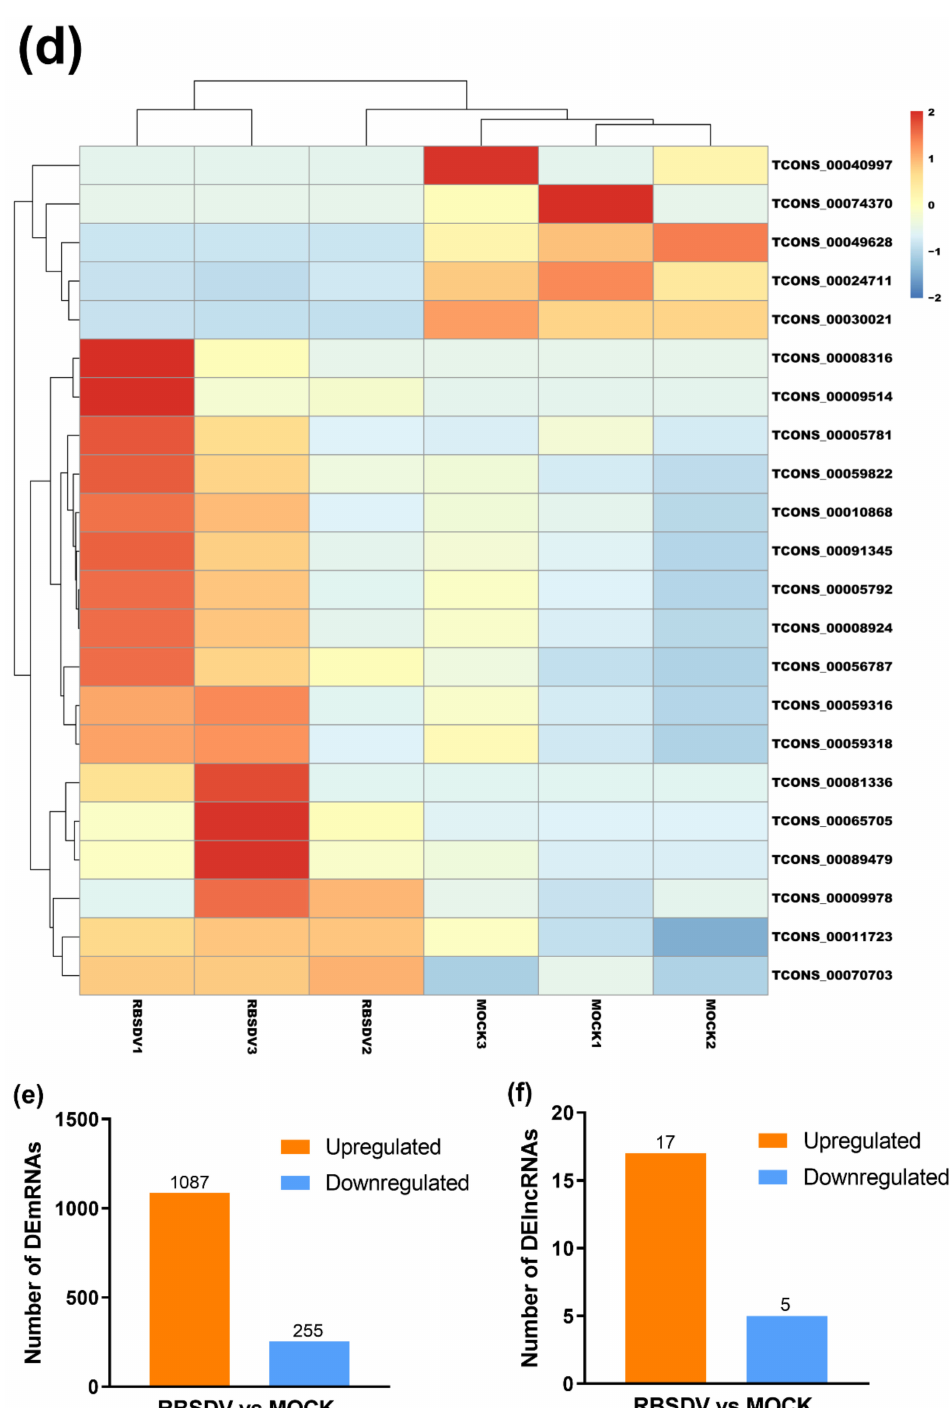
Figure 1. Volcano maps and hierarchical clustering analysis show expression profiles of mRNAs and lncRNAs of RBSDV-infected and mock rice plants. Volcano maps show mRNA expression ( a ) and lncRNA expression ( b ) with fold change ≥ 2.0 and false discovery rate (FDR) < 0.05. Red dots represent upregulated genes, and green dots represent downregulated genes in volcano maps. The heatmaps show significantly expressed mRNAs ( c ) and lncRNAs ( d ) with fold change ≥ 2.0 and FDR < 0.05. The right panel is the color key for fold-change. Red represents upregulation, blue represents downregulation, the brighter image is the greater the fold change; ( e , f ) the number of mRNAs or lncRNAs whose expression significantly changed are